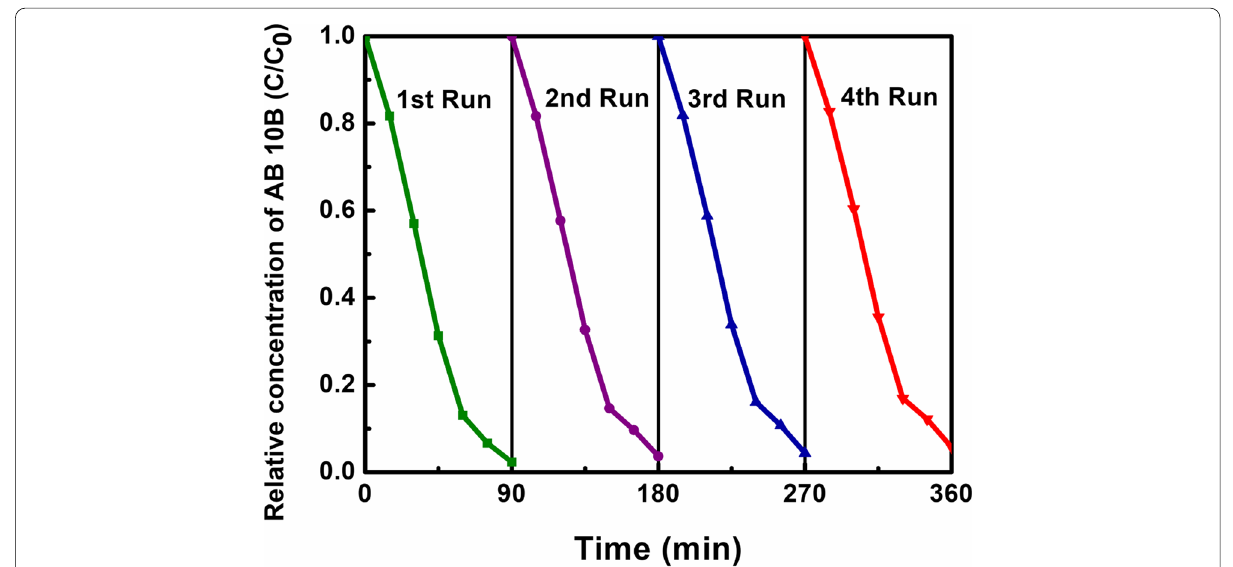
Fig. 19 Recyclability test for